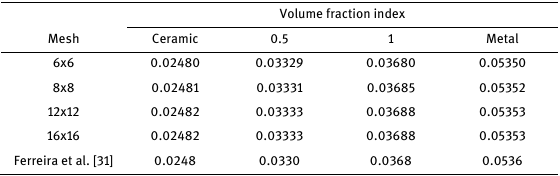
Table 1: Comparison of non-dimensional maximum deflection at the centroid of simply supported FGM plate.